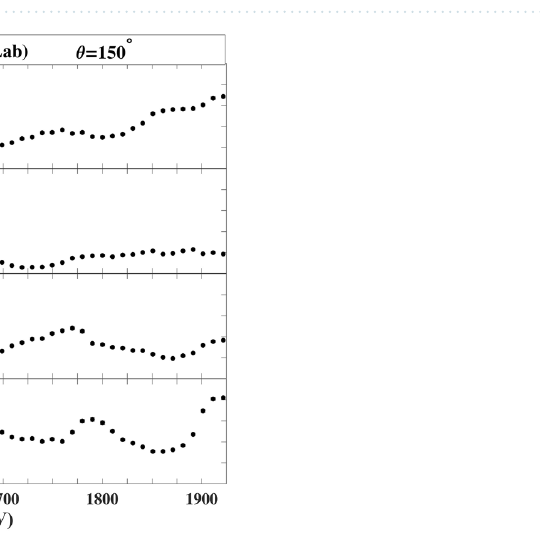
Figure 3. ( a ) The simulated spectrum without mylar and ( b ) the typical measured spectrum in experimental work with 4 µm mylar in front of the particle detector at the detection angle of 150° and for E d,lab = 1.8 MeV at VDGT Lab in Tehran. The interferences between the high energy alpha and proton groups are clearly resolved.